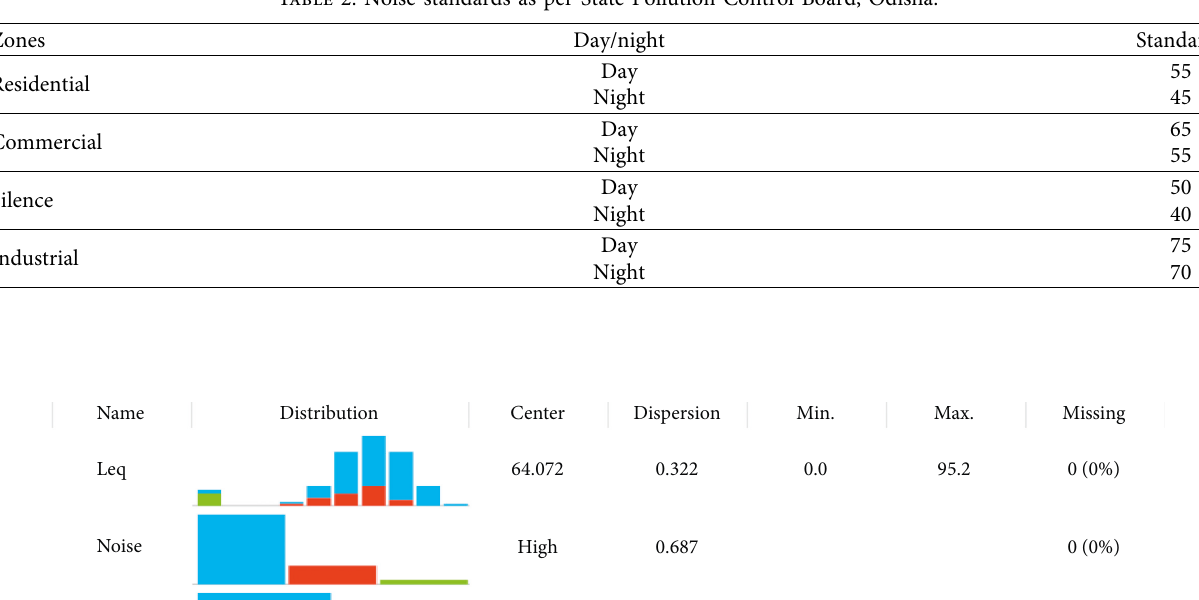
Table 2: Noise standards as per State Pollution Control Board, Odisha.